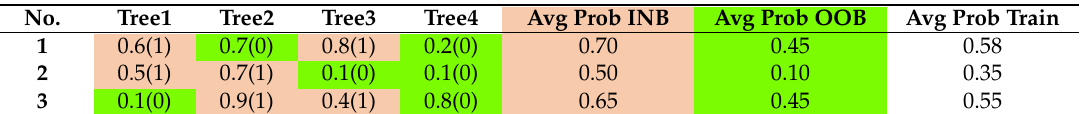
Table 2. Example of Probability matrix and In Bag matrix with estimated probability for each observation based on the average probability.